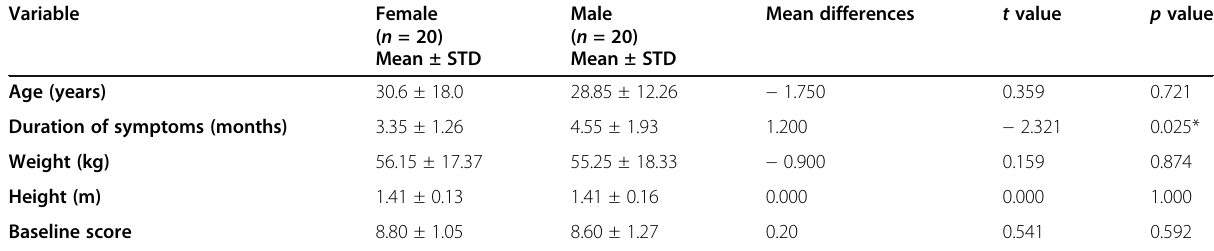
Table 2 The mean comparison of age, duration of symptom, weight, height, and baseline VAS scores between males and females